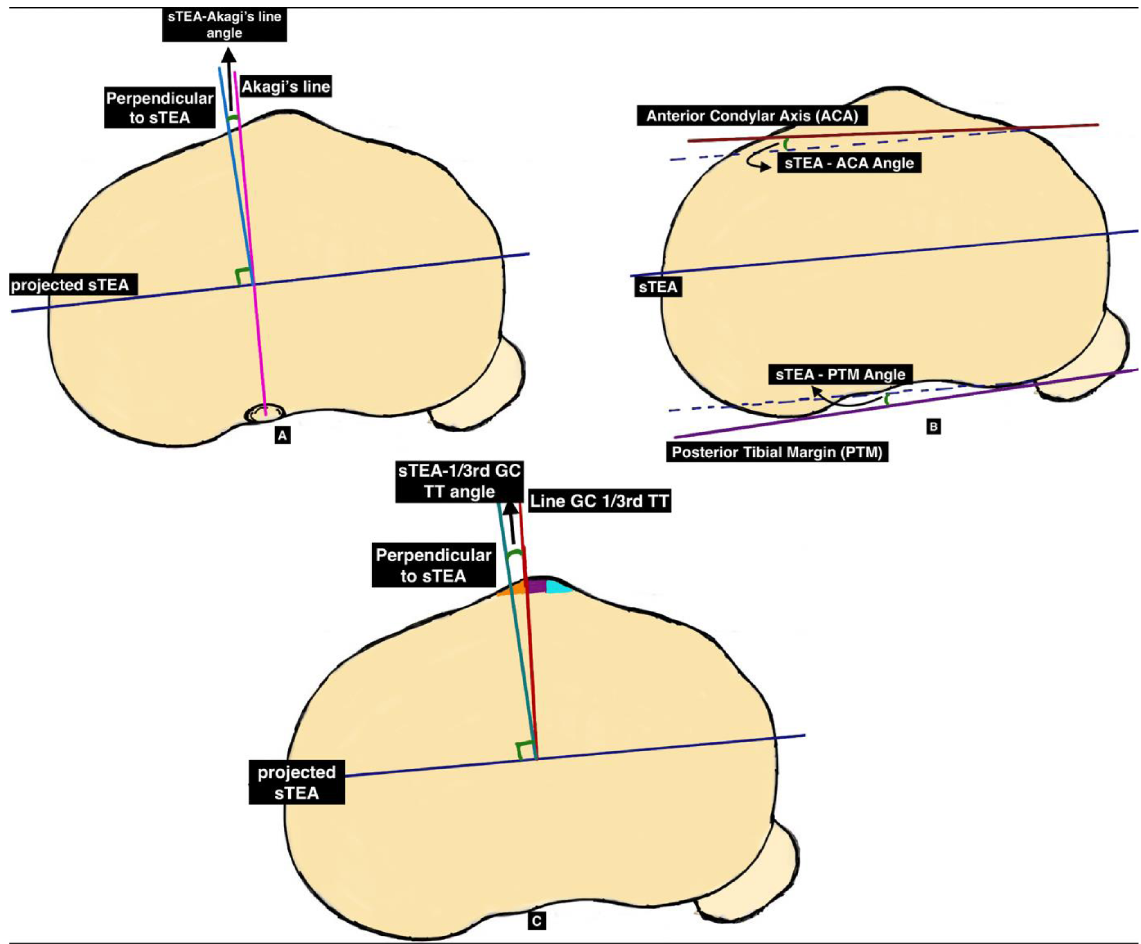
Figure 2. Angles measured on the proximal tibia in relation with sTEA, (A) ’ sTEA – Akagi ’ s line ” , (B) “ sTEA – ACA ” and “ sTEA-PTM ” (C) ’ sTEA – line GC 1/3rd TT ’